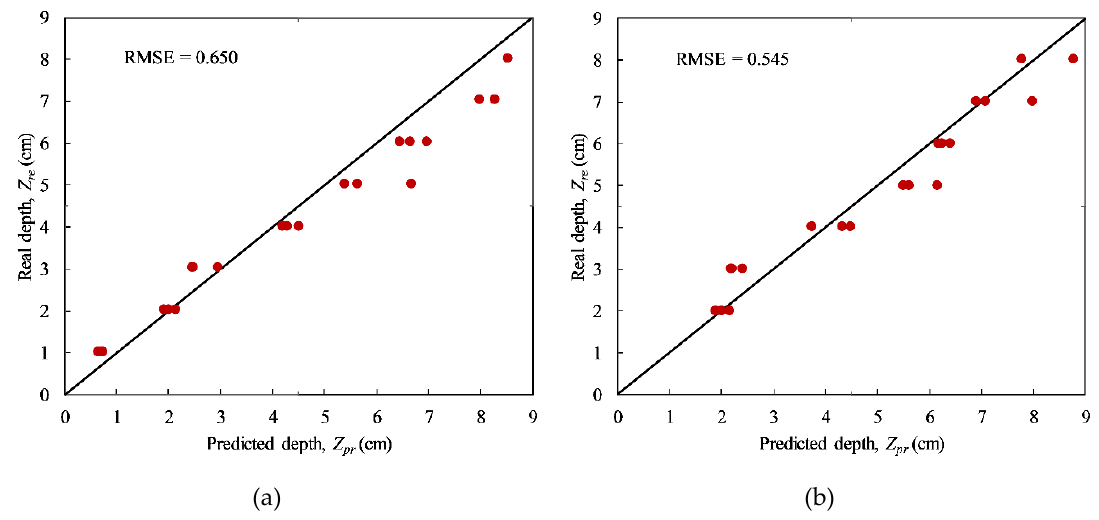
Figure 12. Predicted defect depths under different heating times: ( a ) 15 min and ( b ) 20 min.